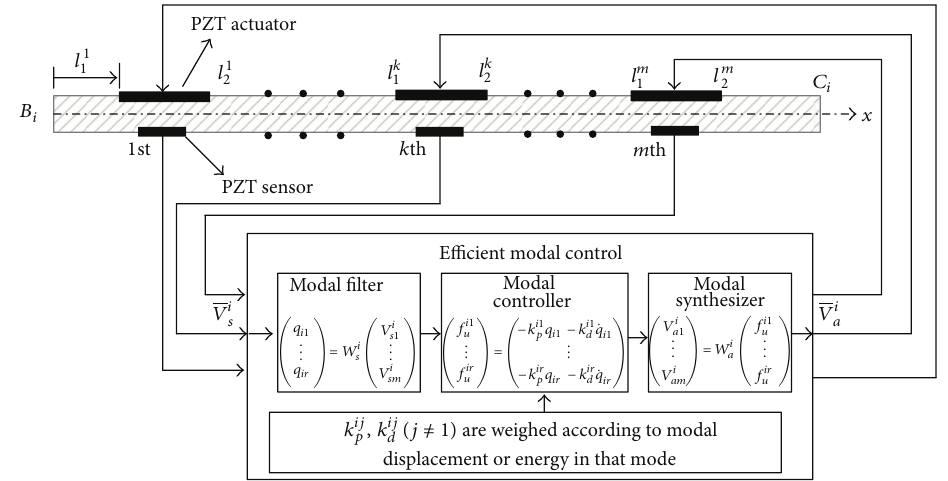
Figure 4: Schematic of efficient modal